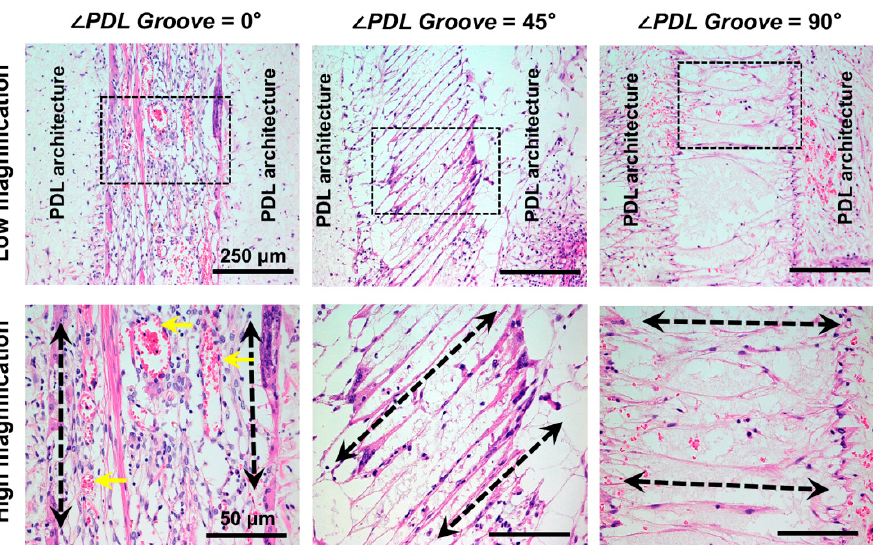
Figure 4. Hematoxylin and eosin (H&E) stained histology is evaluated for fibrous tissue formation and orientations between PDL-guiding architectures at 3 weeks. Black arrowed-dash lines represent the fibrous tissue directionality. Yellow arrows indicate blood vessels. The scale bars of low magnification and high magnification are 250 µm and 50 µm, respectively.